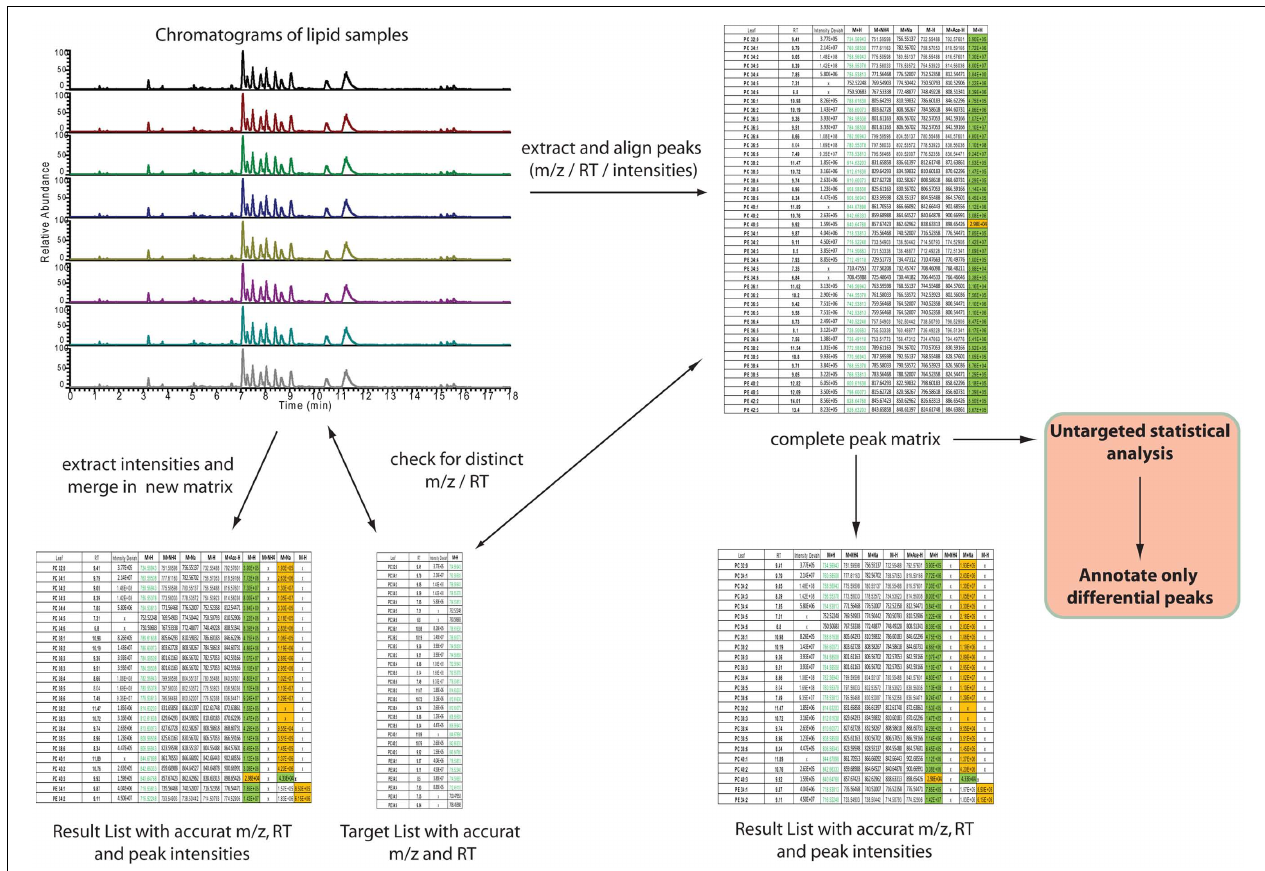
table.The strategy on the right hand side indicates a diverse strategy. Here all peaks are extracted first and these are written into an un-annotated data matrix.This matrix can then be compared against a target list (same as for the first strategy) or used for statistical analysis of significantly differential peaks, which then have to be